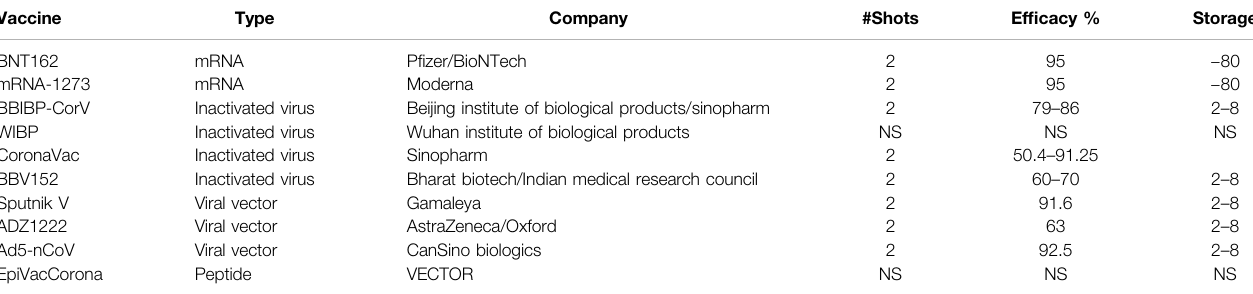
TABLE 1 | Overview of the ten vaccines that have been approved by one or more regulatory agencies